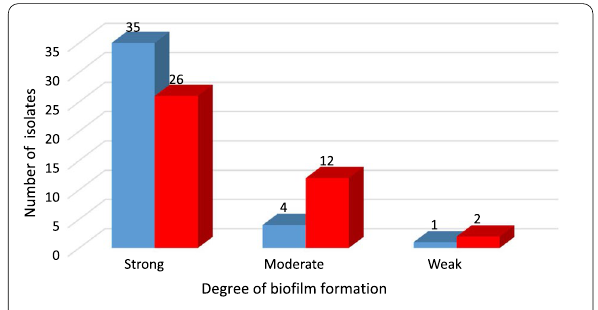
Fig. 4 Relative number of isolates showing strong, moderate, and weak biofilm formation of Streptococcus mutans test isolates recovered from dental plaque and saliva samples